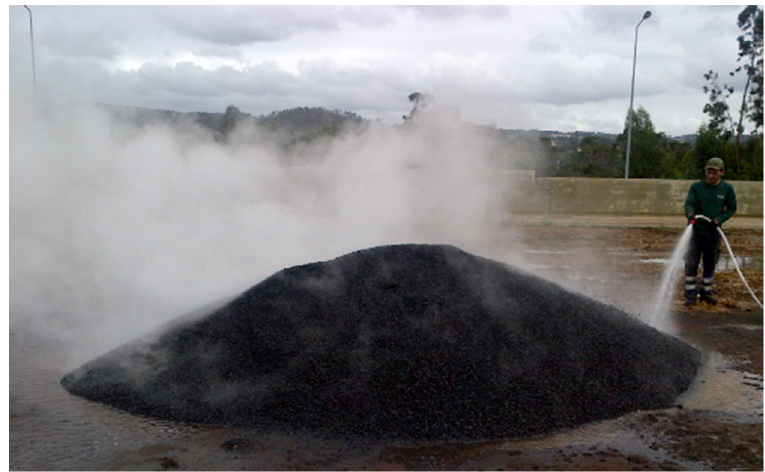
Figure 15. Production plant operator extinguishing an auto-ignition in a pile of torrefied biomass pellets.